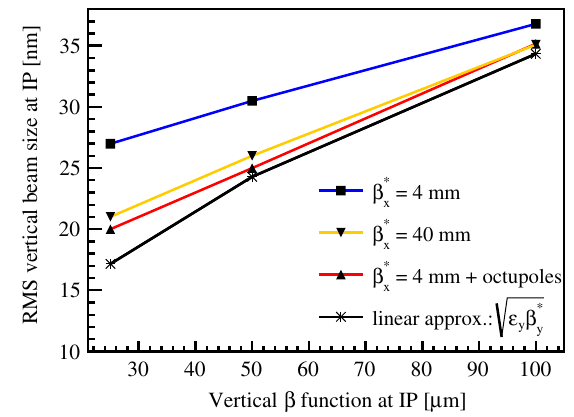
FIG. 2. Expected vertical beam size in ATF2 for three consid- ered β (cid:1) y values and proposed mitigation